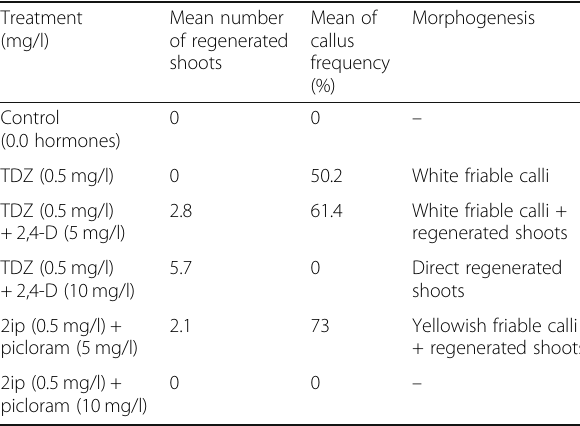
Data were based on three replicate jars with three leaf